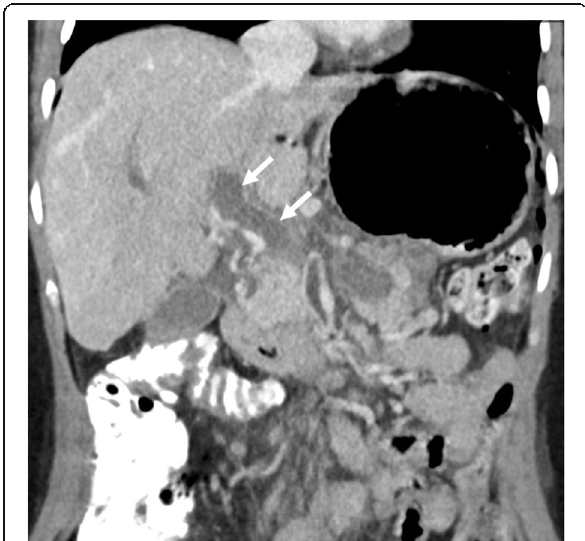
Fig. 1 A 34-year-old female with myelofibrosis underwent splenectomy 3 days ago now presenting with right upper quadrant pain and elevated liver enzymes. Coronally reformatted postcontrast CT image demonstrates low attenuating filling defect within the main portal vein (arrows) with no enhancement consistent with bland thrombus